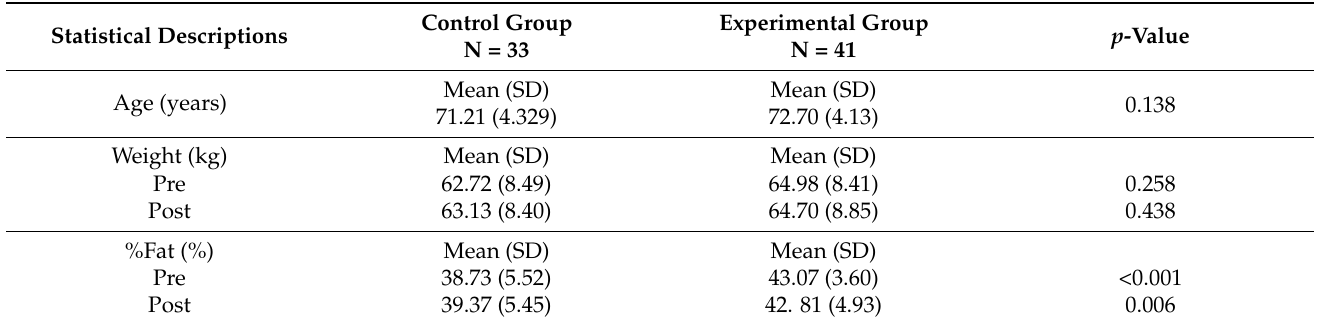
Table 1. Descriptive statistics by age group and anthropometric